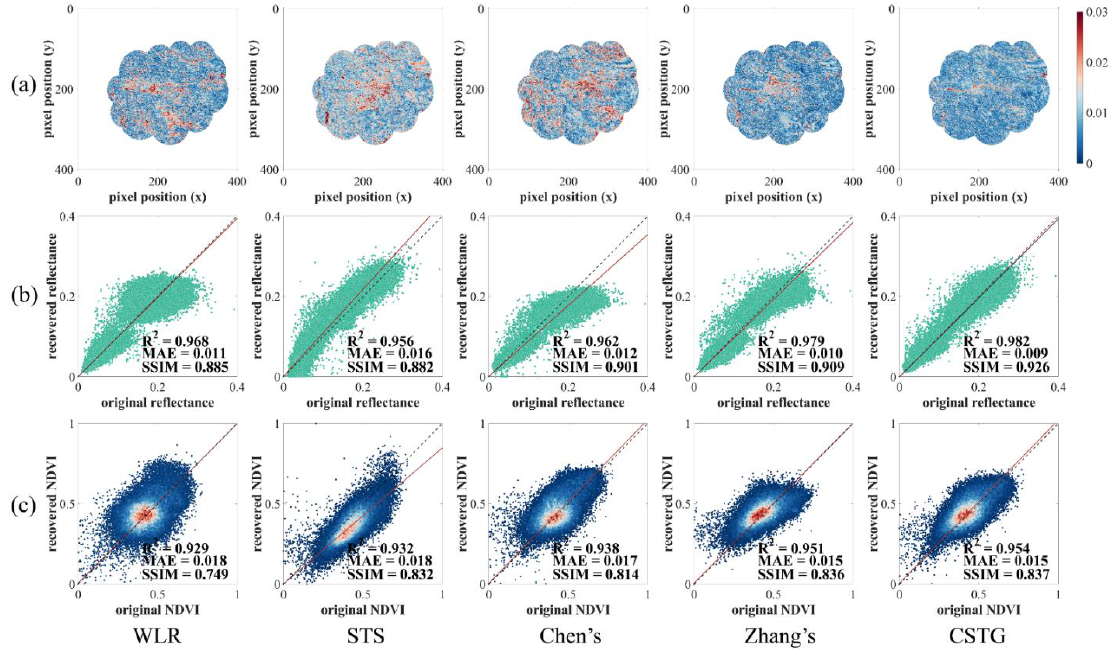
Figure 8. Visualization maps of quantitative analysis between recovered and original values using different methods with a large and intensive mask area: ( a ) pixel-level error maps; ( b ) regression analysis of the normalized reflectance; ( c ) regression analysis of the NDVI. In ( b , c ), the solid red lines denote the regression lines and the dashed black lines denote the 1:1